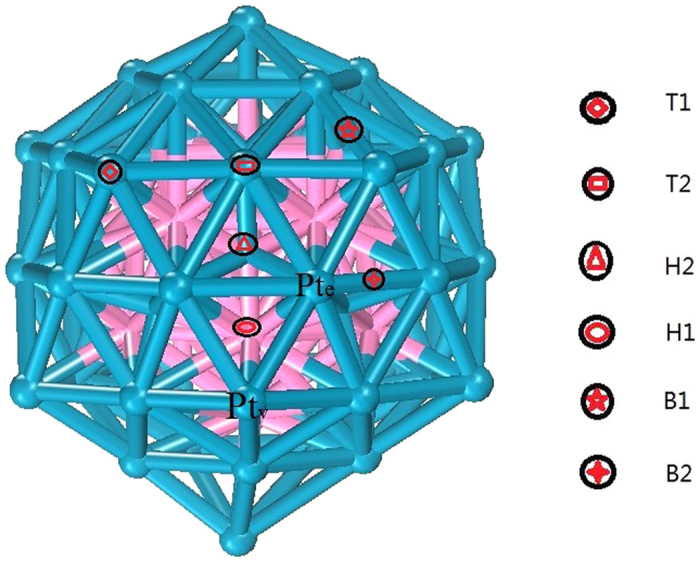
O adsorption sites of the W13@Pt42 core-shell structure.